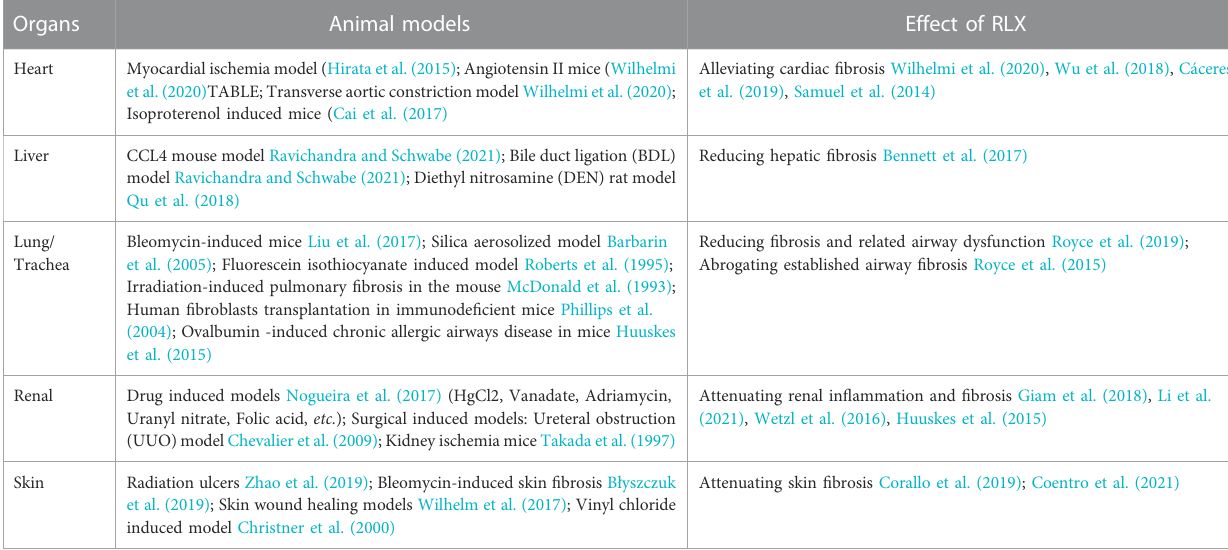
TABLE 1 Animal models and the effect of RLX applied to different organs. Organs Animal